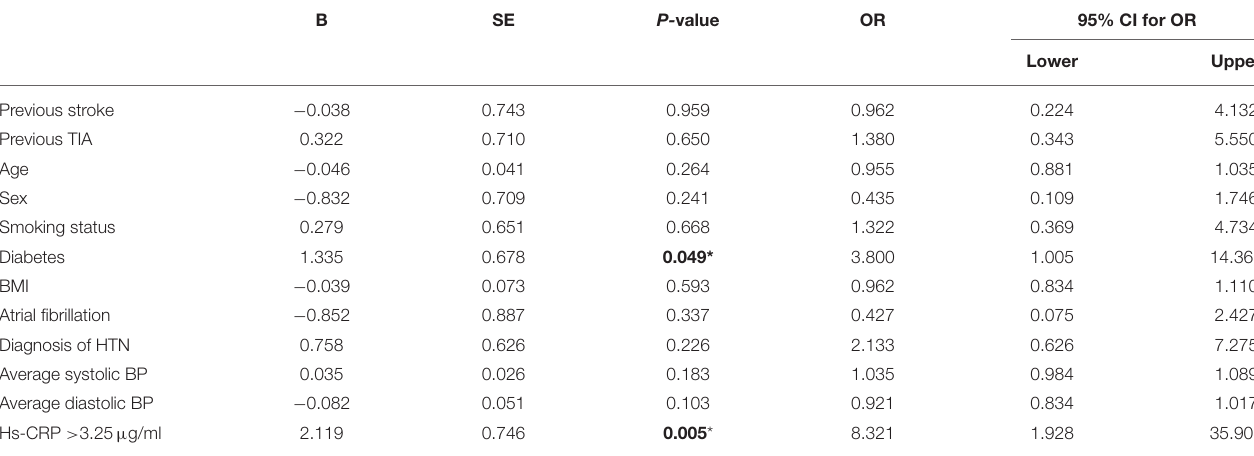
TABLE 3 | Levels of hs-CRP > 3.25 µ g/ml optimally predict further ischemic events. B SE P- value OR 95% CI for OR